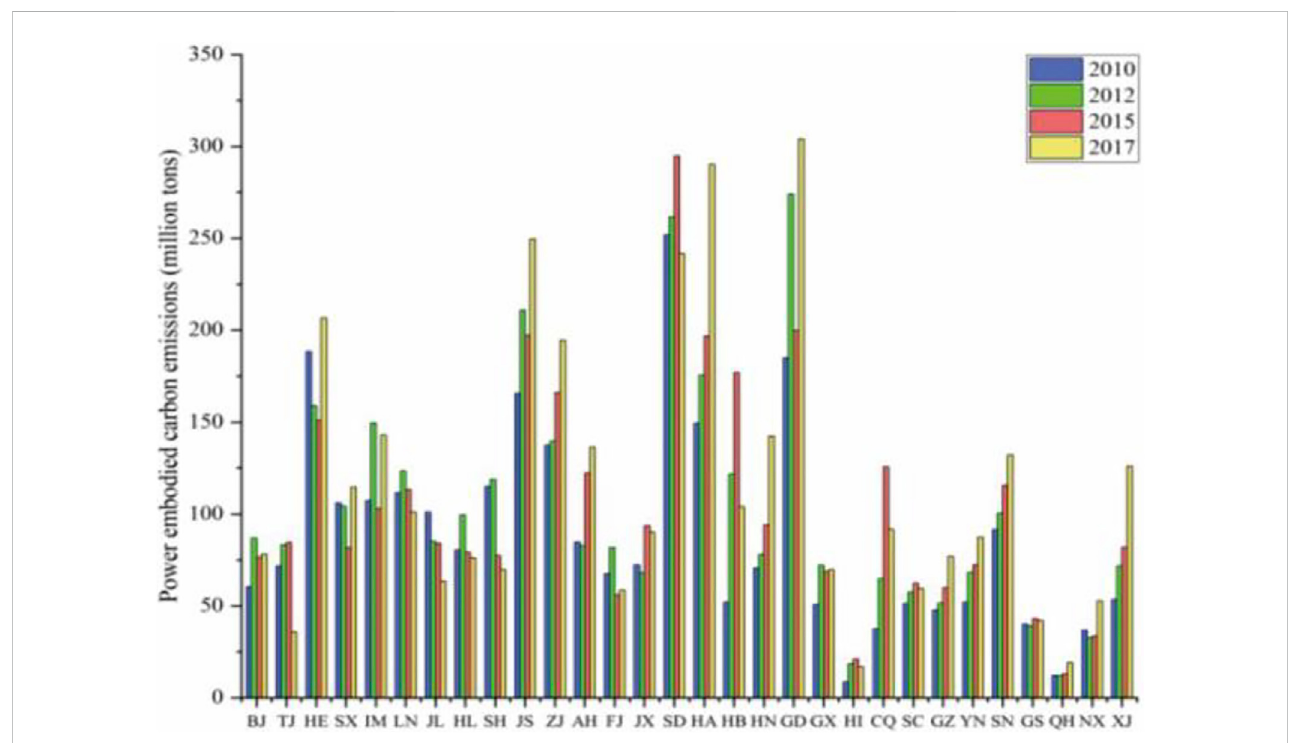
Embodied carbon emissions from power sector in provinces of